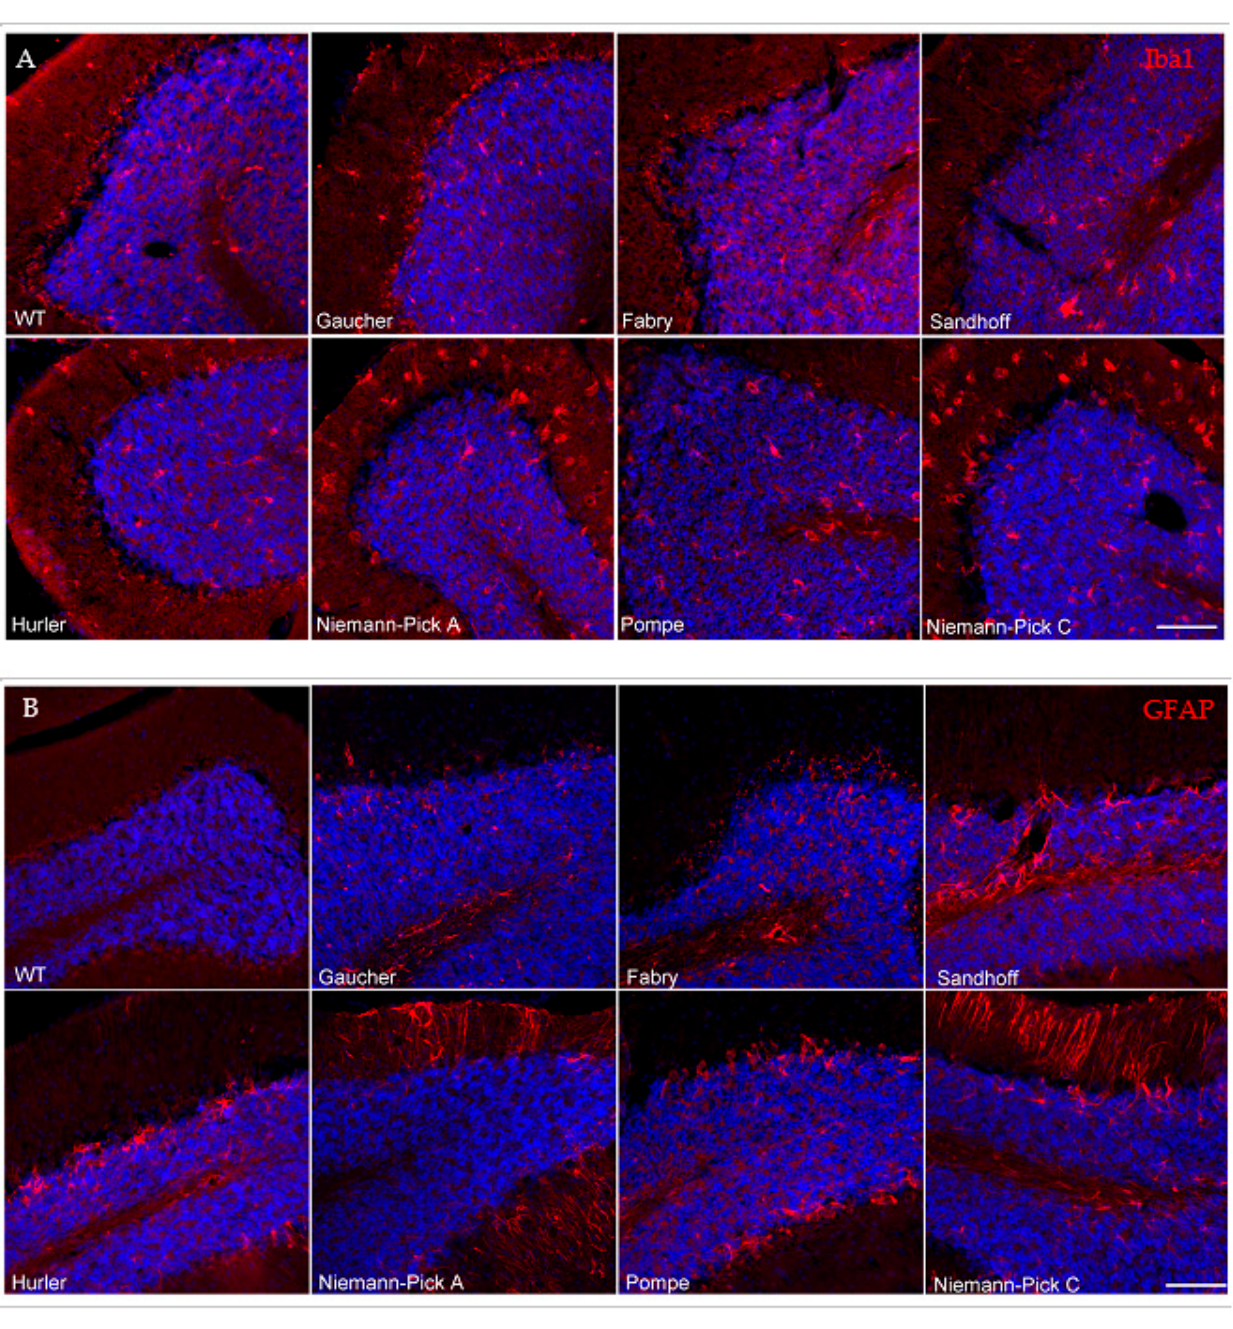
Figure 3. Cerebellar neuroinflammatory profiles of lysosomal storage disease model mice differ in severity and distribution. Representative images taken of Iba-1 immunoreactivity ( A , red) and GFAP immunoreactivity ( B , red) in the cerebella of seven LSD models. Sandhoff, Niemann–Pick A, Hurler, Pompe and Niemann–Pick C disease models mice all exhibited microglial cell activation in various cerebellar regions. Sandhoff and Pompe disease models exhibited microglial activation primarily in the granular and white matter cerebellar regions. Both Niemann–Pick disease models displayed widespread microglial activation in all layers. Hurler mice displayed mild to moderate microglial cell activation, primarily in the granular layer. GFAP immunoreactivity was prominent in Sandhoff, Niemann Pick A and C and Pompe disease models, with little to no changes observed in the other models. Nuclei are shown in blue with DAPI counterstaining (scale bar 100 µ m). Brains from these various LSD models also displayed dissimilarities in the distri- bution and extent of astrogliosis, determined via GFAP immunofluorescence (Table